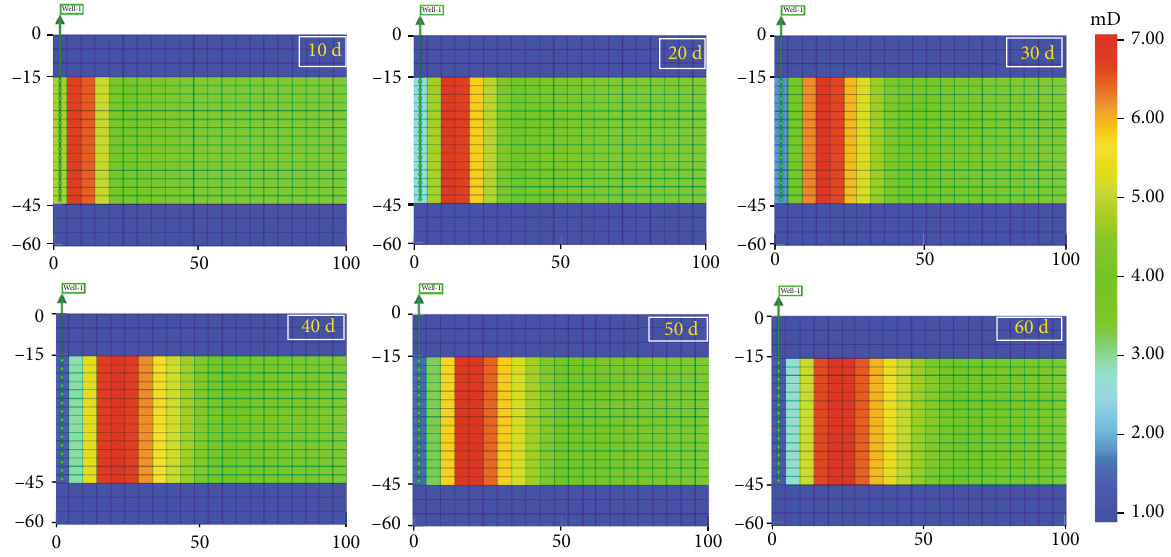
Figure 6: Evolution of spatial distribution of